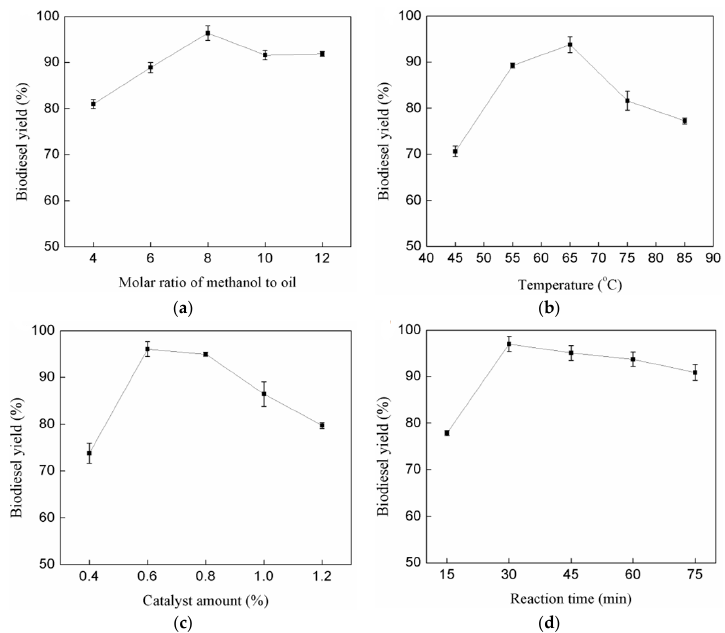
Figure 2. Effects of ( a ) molar ratio of methanol to oil (with a fixed temperature of 65 °C, 0.8% NaOH, and a reaction time of 30 min); ( b ) temperature (with a fixed methanol:oil molar ratio of 8:1, 0.8% NaOH, and a reaction time of 30 min); ( c ) catalyst amount (with a fixed methanol:oil molar ratio of 8:1, a temperature of 65 °C, and a reaction time of 30 min); and ( d ) reaction time (with a fixed methanol:oil molar ratio of 8:1, a temperature of 65 °C, and 0.6% NaOH) on transesterification of soursop seed oil.